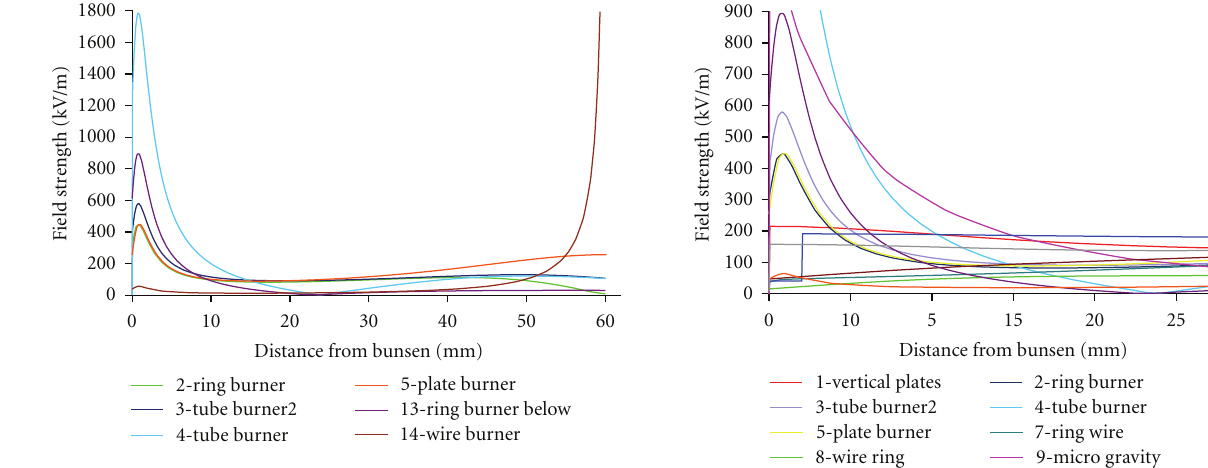
Figure 5: Field strength versus distance from the burner for medium field strengths.